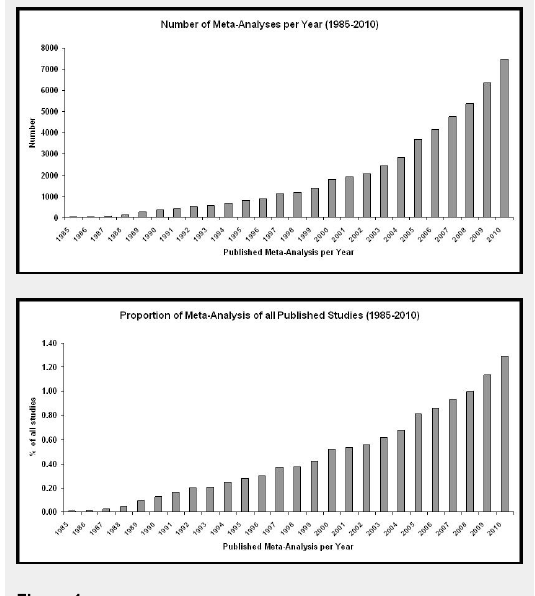
A: Increase in number of meta-analyses in MEDLINE (meta- analysis[mh] OR meta-analysis[pt] OR meta-anal*[tw]) from 1985 to 2010. B: Increase in proportion of meta-analyses of all published studies in MEDLINE from 1985 to